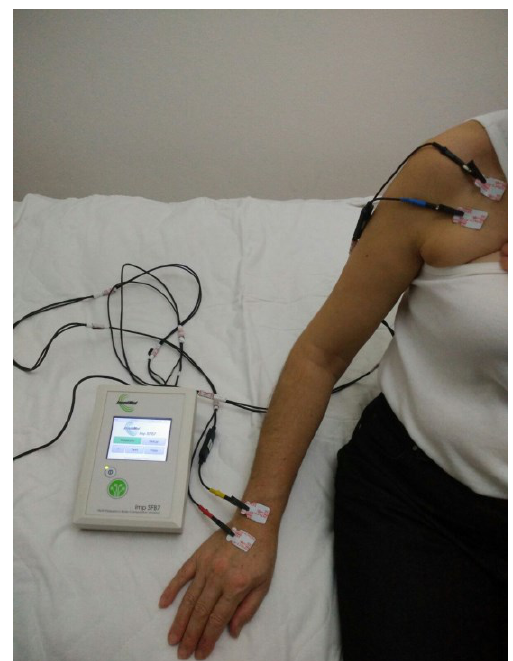
Figure 1. Placement of electrodes and the BIS